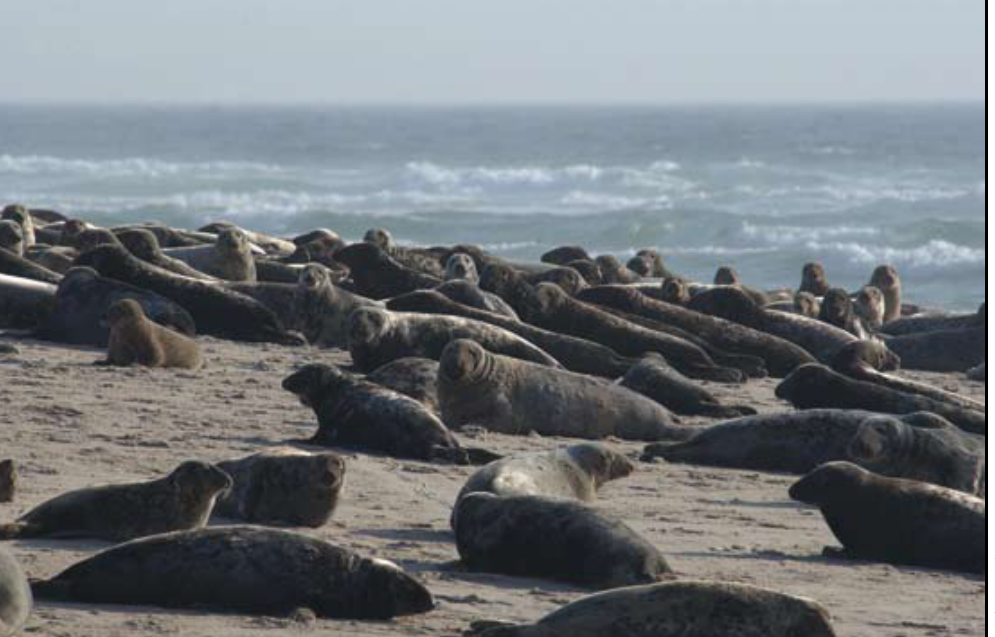
Fig. 8. A crowded beach on Sable Island. (Photo: Yves